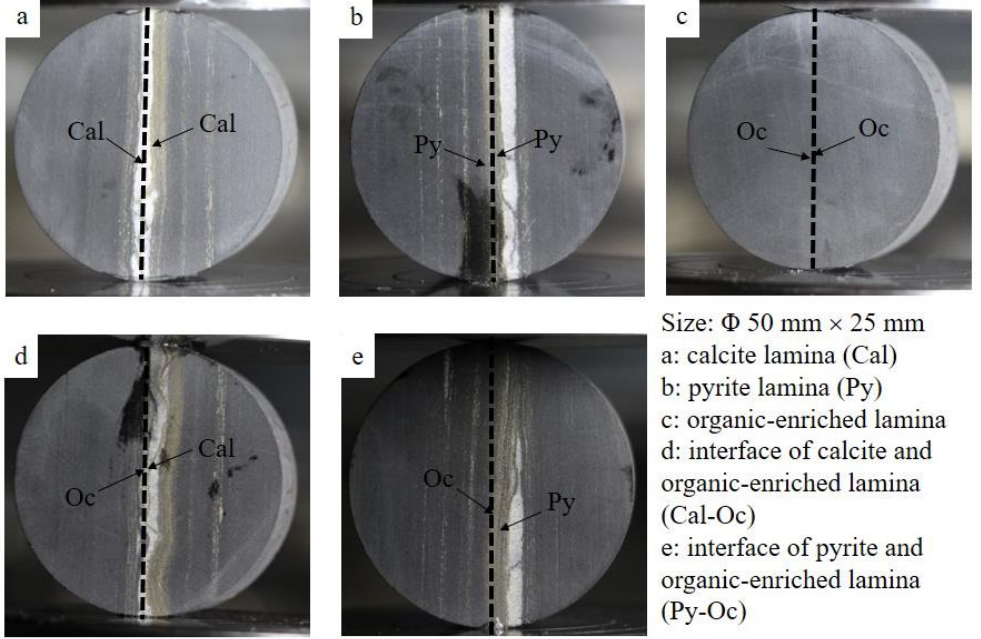
Figure 2. Brazilian discs prepared with various laminae.